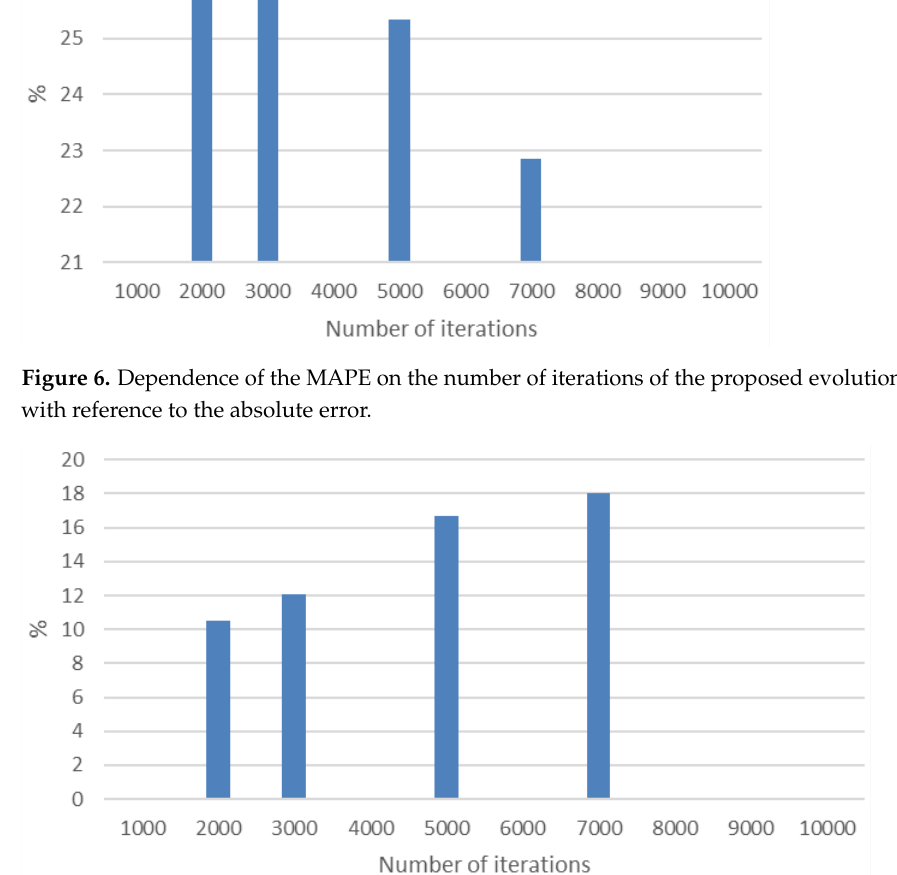
Figure 6. Dependence of the MAPE on the number of iterations of the proposed evolutional method, with reference to the absolute error.